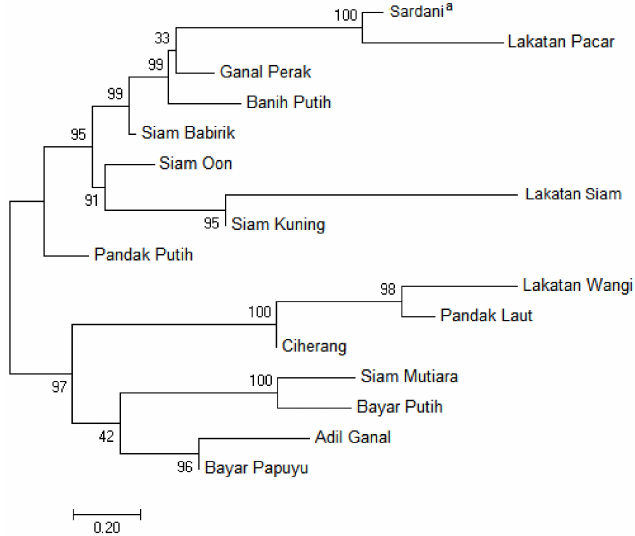
Figure 4. Phylogenetic tree of the tidal swamp rice inferred from the combined of chloroplast trn L-F and nuclear IGS sequences. The numbers above branches indicate bootstrap values inferred from 1000 replicates ( a an